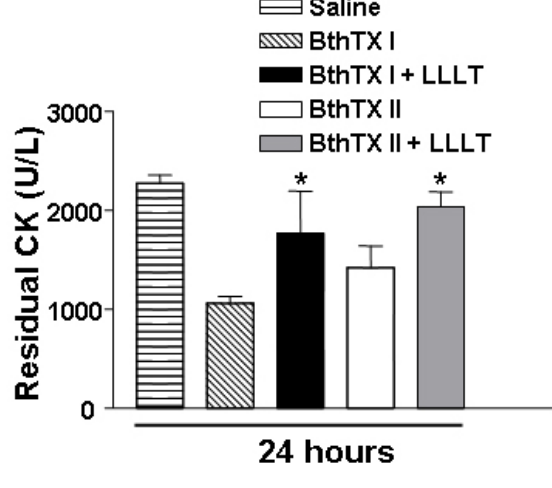
Figure 2 . Leukocyte influx into the gastrocnemius muscle induced by intramuscular injection of 2 mg/ kg of BthTX-I (black bar) or BthTX-II (gray bar). ( A ) Total leukocytes, ( B ) polymorphonuclear cells, and ( C ) mononuclear cells. * p < 0.05 versus the corresponding myotoxin group.